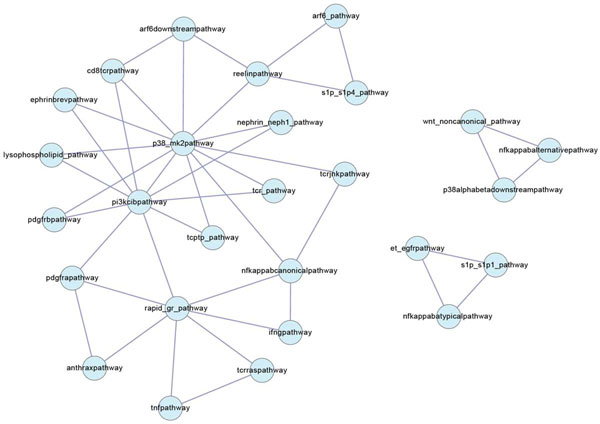
Pathway cross-talk cliques. The nodes indicate the pathway, and the edges are the pathway pairs which have no common gene and are not SIPs, but are identified as highly functional relations by FBA.